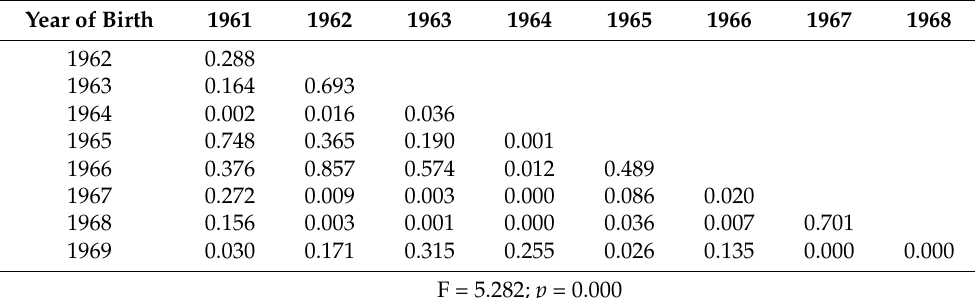
Table 4. Differences in body mass index values presented by year of